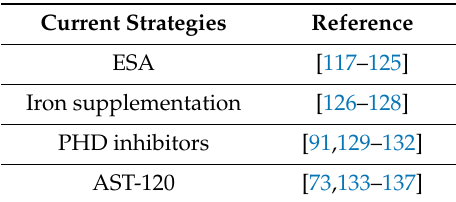
Table 4. Current strategies used to treat renal